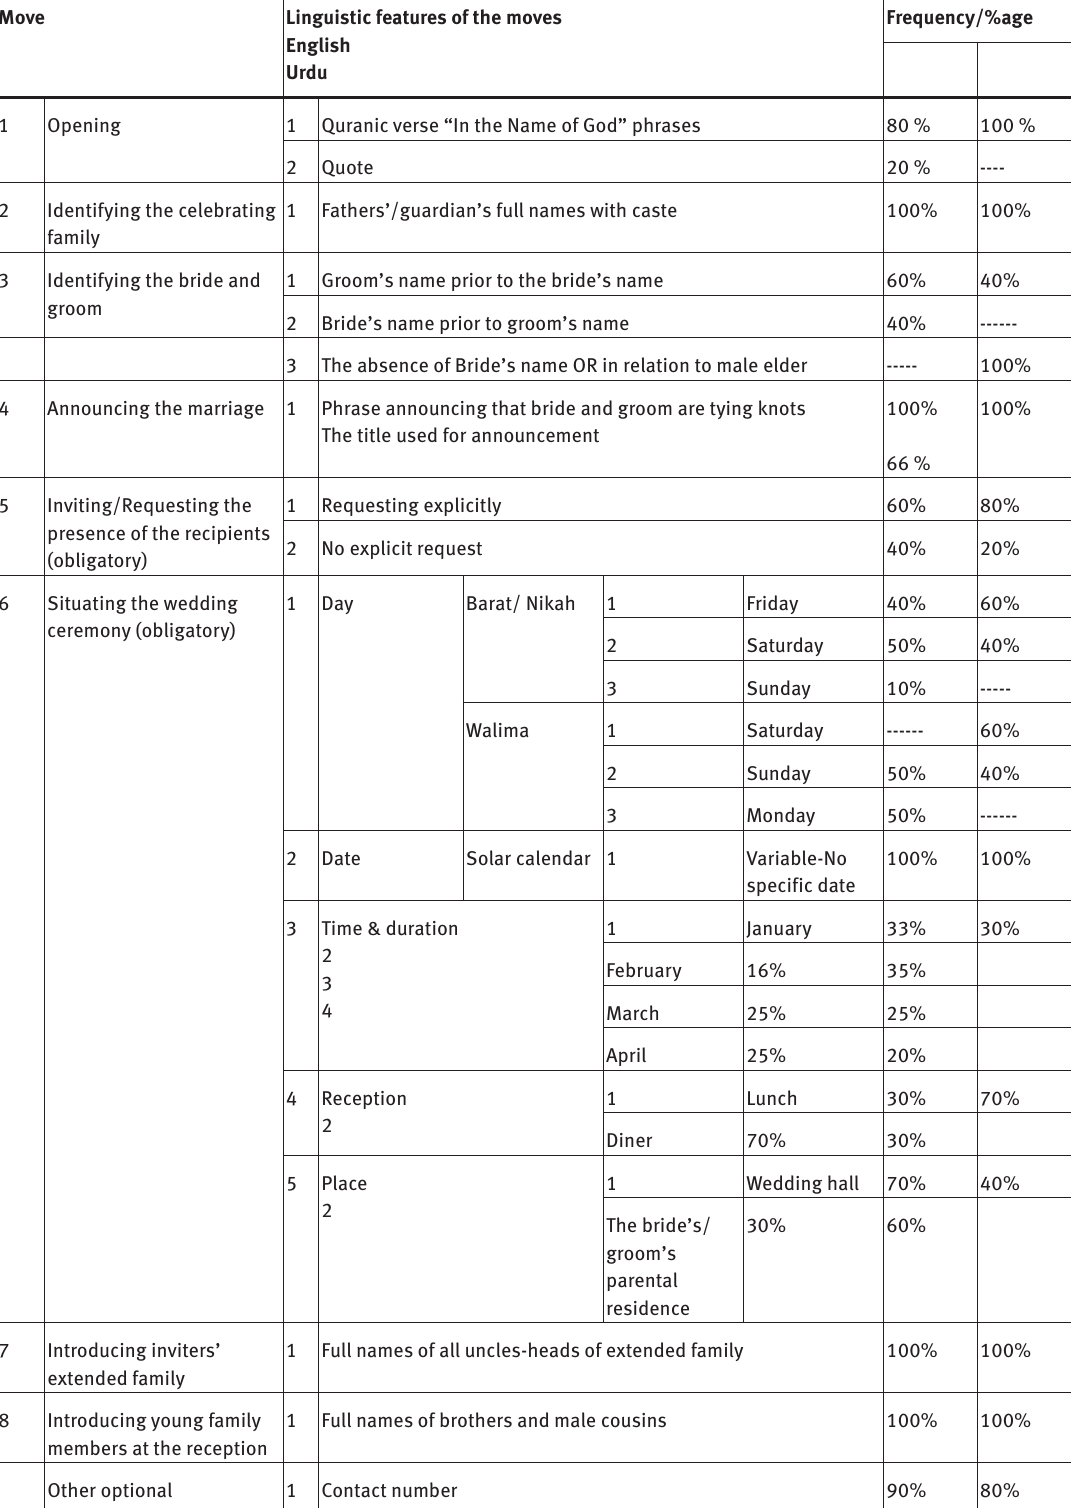
Table 1. Observed Frequency of Component Moves in Pakistani English and Urdu wedding